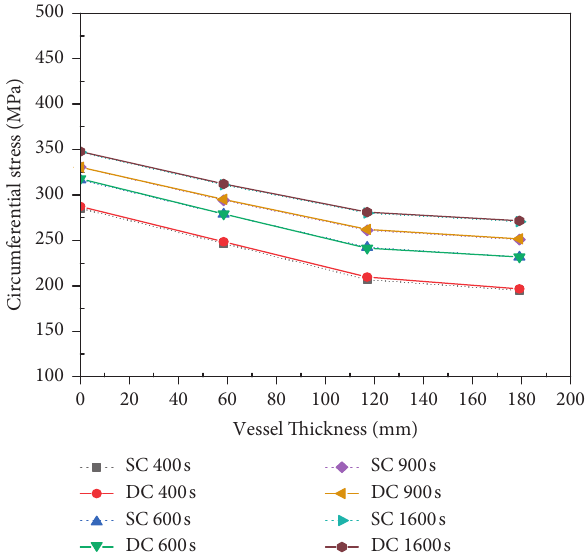
Figure 13: Comparison of circumferential stress estimations from PTS transient based on direct coupling and sequential coupling- simulation methods (SC – sequential-coupling method and DC – direct-coupling method).